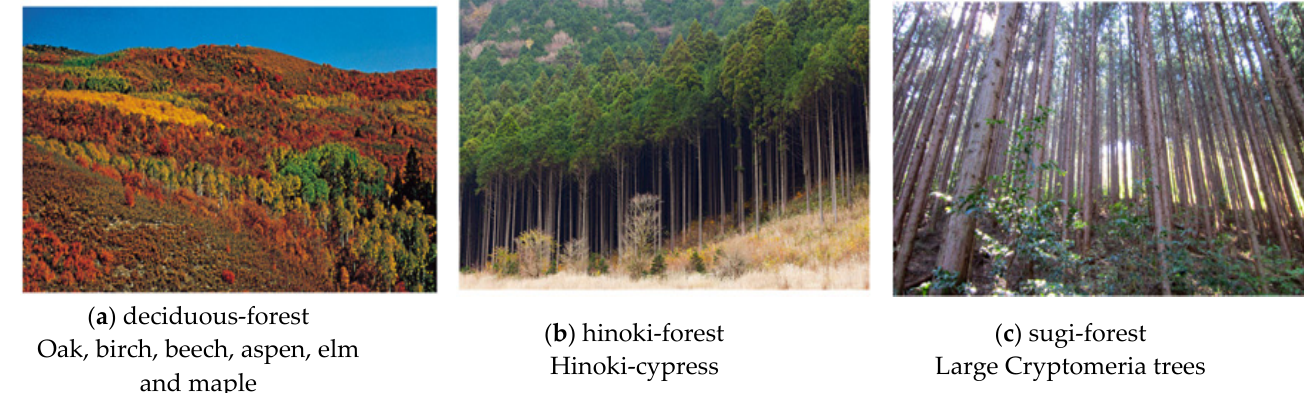
Figure 5. Illustrations of the three forest types from the ground view.